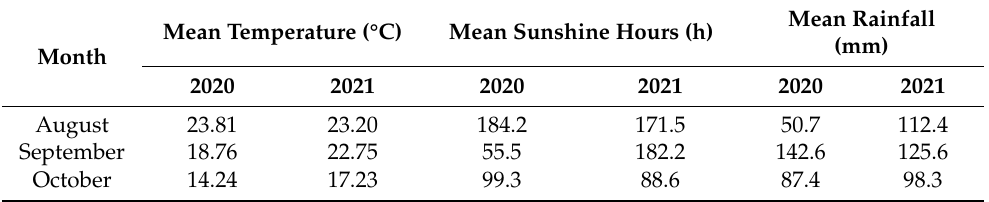
Table 1. Mean temperature and mean sunshine hours during the growing year of common buckwheat.